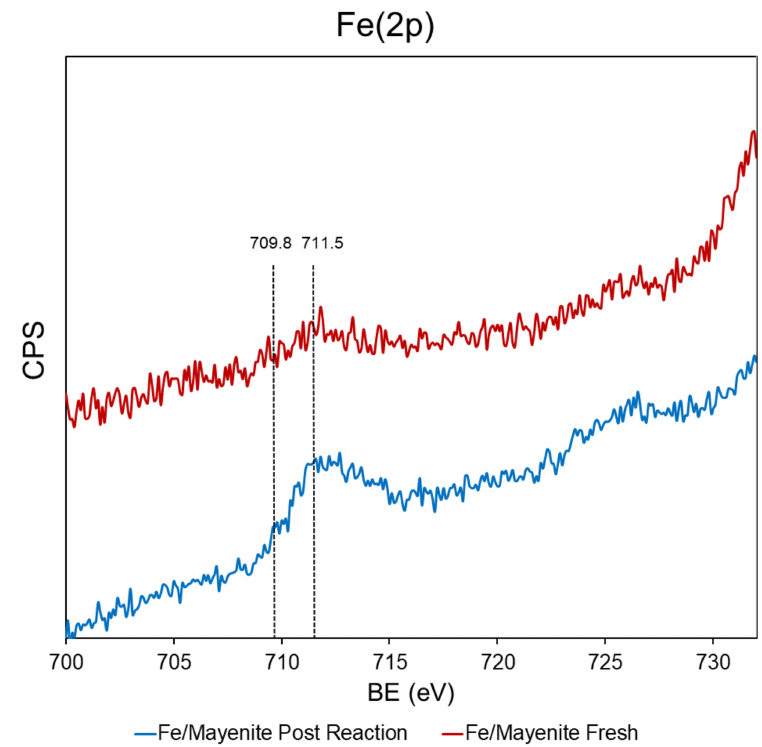
Figure 7. XPS spectra for the Fe (2p) of the Fe / mayenite (2% Fe) before and after